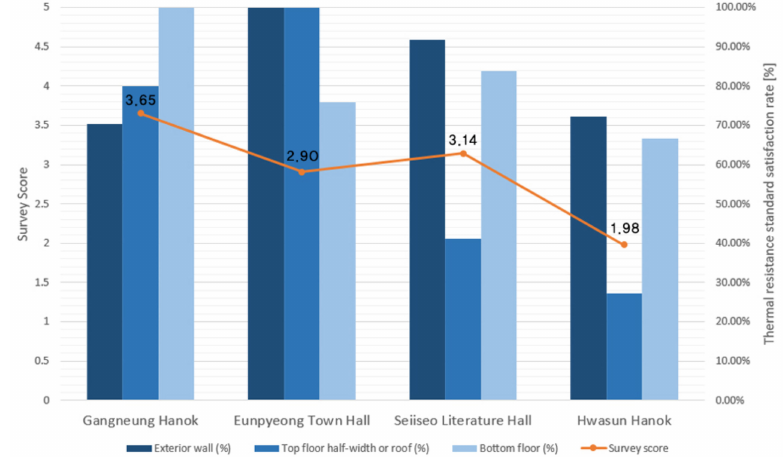
Figure 3. Comparison of heat resistance and survey scores (Frost Descent).